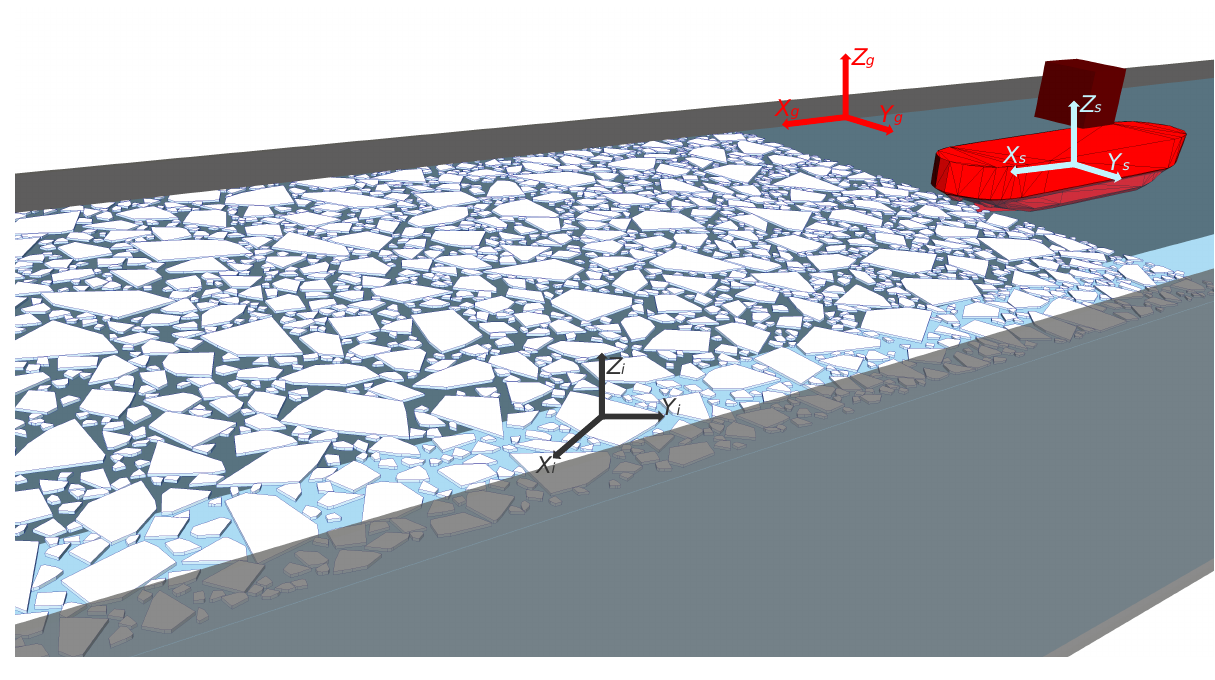
Figure 4: Simulation scene of the numerical